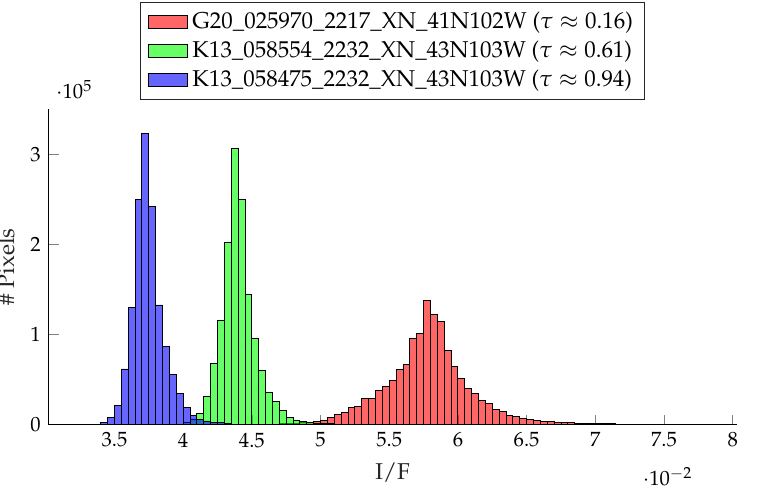
Figure 4. Radiance distributions for the three selected CTX images. The higher the optical depth becomes, the darker the images and the lower the contrast.